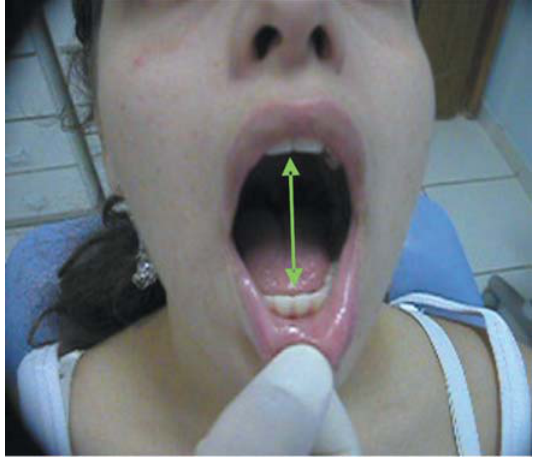
FIGURE 3- Re-establishment of the normal jaw dynamics